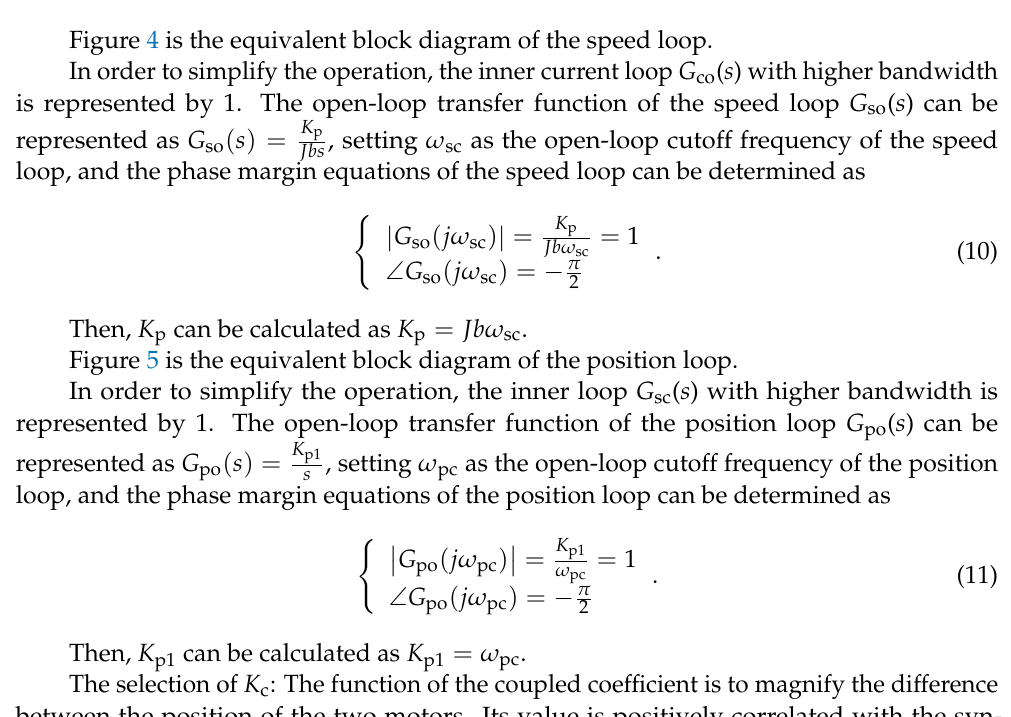
Figure 5 is the equivalent block diagram of the position loop.